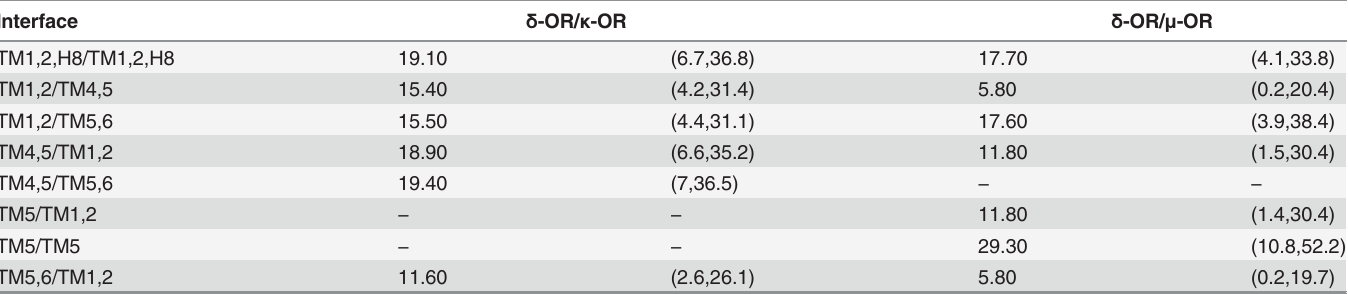
Table 2. Fraction of the observed hetero-dimeric interfaces during five independent MD simulations of the μ -OR/ δ -OR and δ -OR/ κ -OR systems. Interface